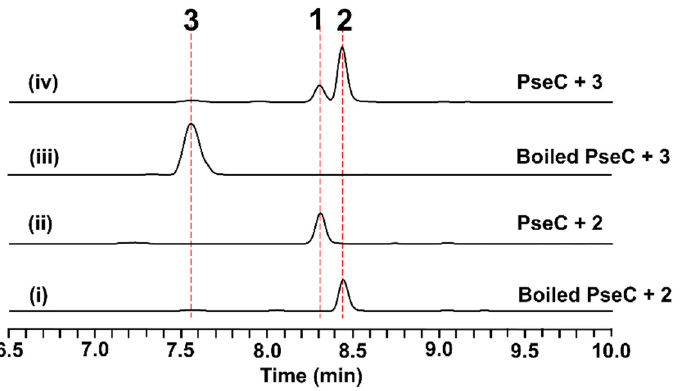
Figure 3. Biochemical characterization of the methyltransferase PseC in vitro. The traces are of HPLC with λ = 312 nm.